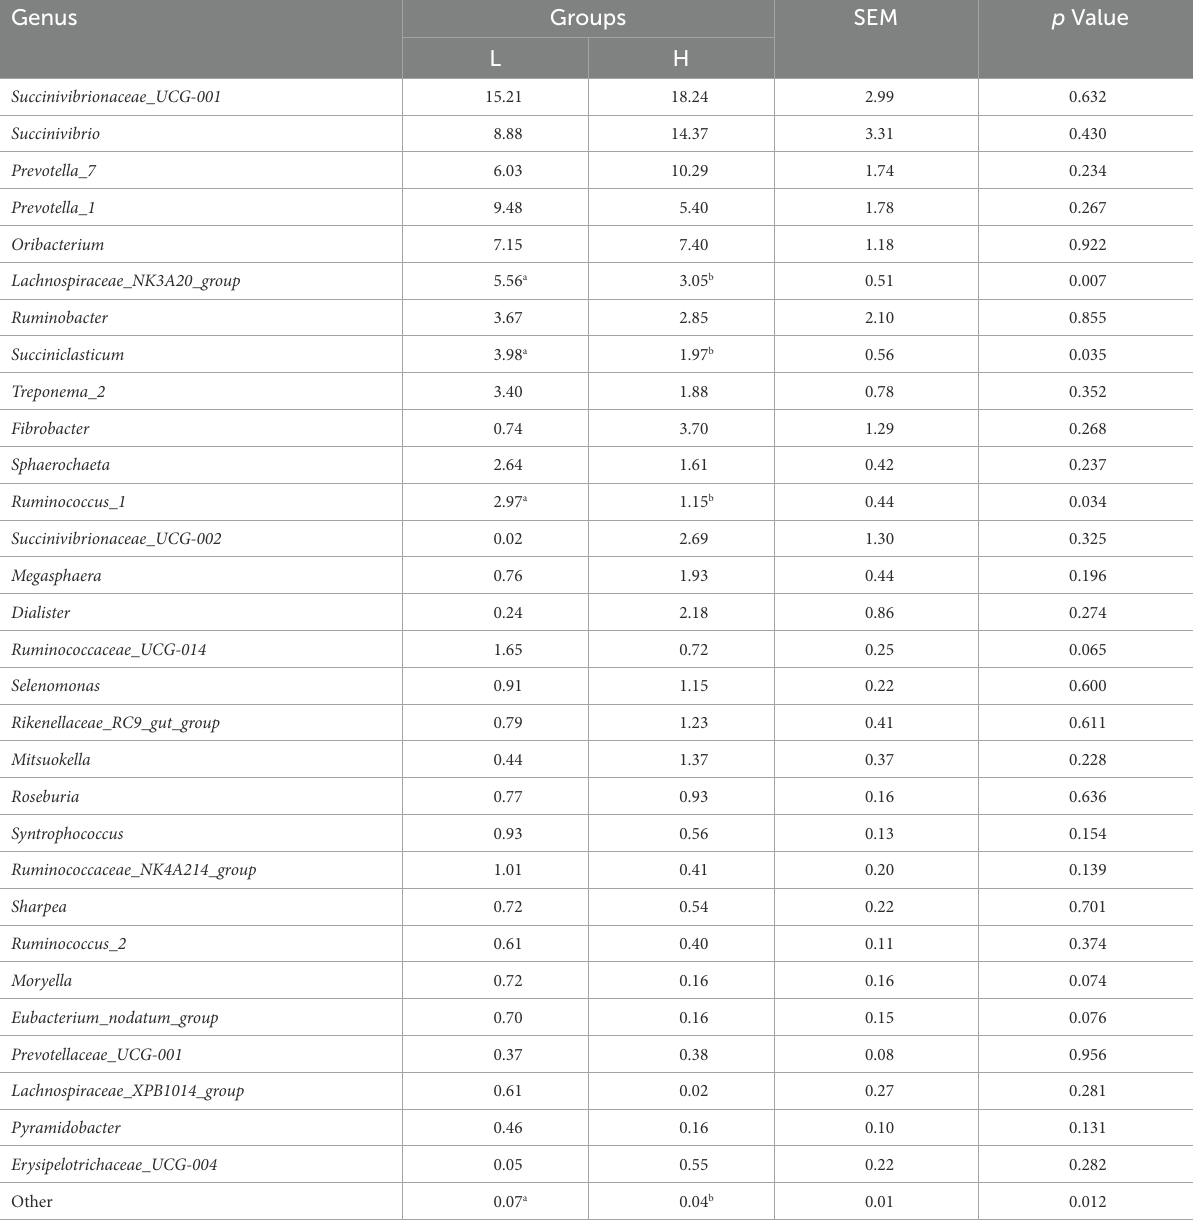
TABLE 6 Genus-level taxonomic composition of the top 30 rumen microbial communities